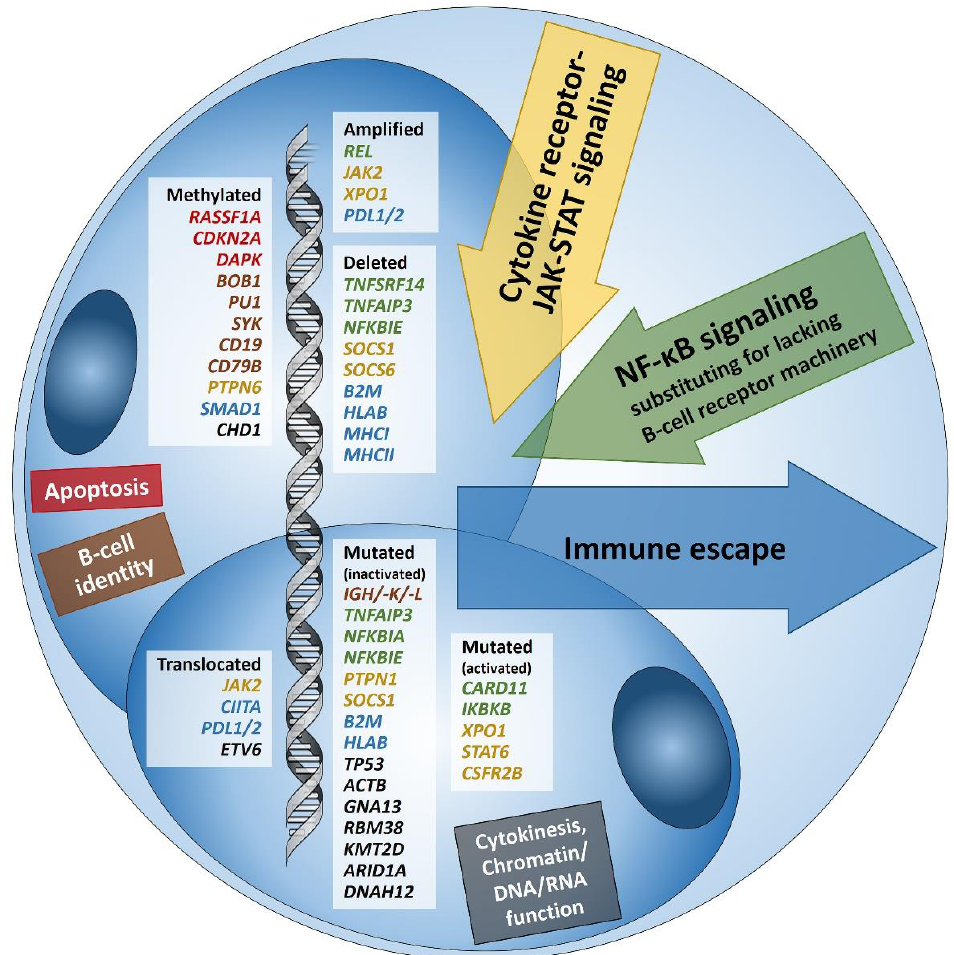
Figure 1. Summary of known genetic aberrations in classic Hodgkin lymphoma (cHL) arranged according to aberration type and color-coded according to the affected cellular process that they dysregulate in Hodgkin and Reed-Sternberg cells; genes encoding for proteins related to apoptosis are in red, to B-cell identity — in brown, to cytokine (mainly JAK-STAT) signaling — in orange, to NF- κB signaling— in green, to immune escape — in blue, and to cytokinesis, chromatin/DNA/RNA functions — in black; inactivating translocations of SOCS1 that are characteristic of pediatric cHL [13] are not sown.